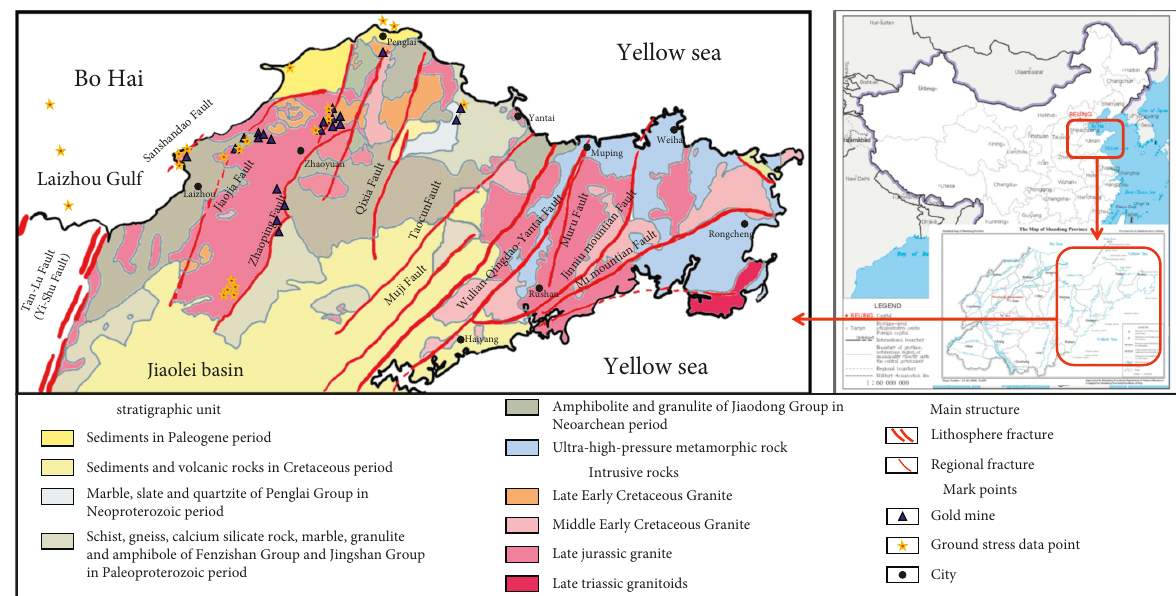
Figure 1: Outline diagram of the new structure in Shandong Province [10].